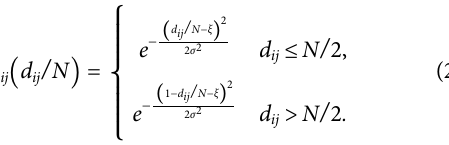
FIGURE3| Panel (A) showstheerrors e ( μ ) (black)and e ( ] ) (blue)with e ( c ) (cid:1) exact eigenvalues derived by a discrete Fourier transformation, see Eq. 22 . The errors are displayed in dependence of the system size N (number of oscillators). The relative coupling range is set to p (cid:1) 0 . 1. Panel (B) and (C) show the approximated eigenvalues given by Eqs. 26 , 27 , respectively, depending on the relative coupling range p for different values of k